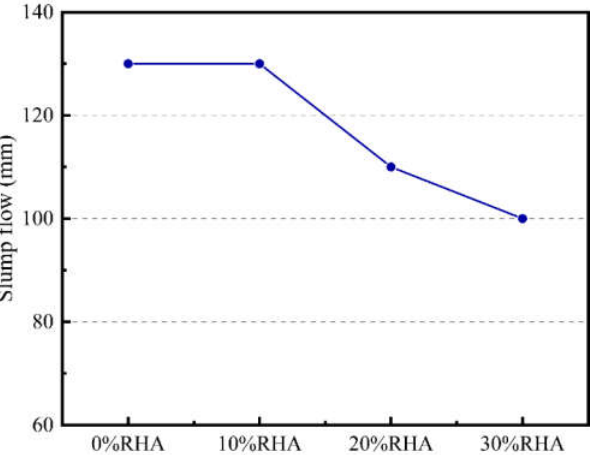
Figure 4. The impact of RHA replacement ratios on the workability of fresh concrete mixtures. With the gradual increase in the RHA substitution rate, the slump value of 20% RHA and 30% RHA decreased by 15.38% and 23.08%, respectively, compared with 0% RHA. This may be due to the increase in the RHA replacement ratio, leading to an increase in the porosity and total specific surface area of the cementitious material (Table 1). The sys- tem absorbs more water, thus causing a reduction in the free water within the paste, which will increase the mixtures’ friction and discourage the flow, which in turn leads to the decrease in the concrete slump and reduced workability. This finding is similar to that of Amin et al. [15], who reported that the slump of fresh concrete mixtures increased with increasing RHA content, and the mixtures with 30% RHA content had the worst worka-